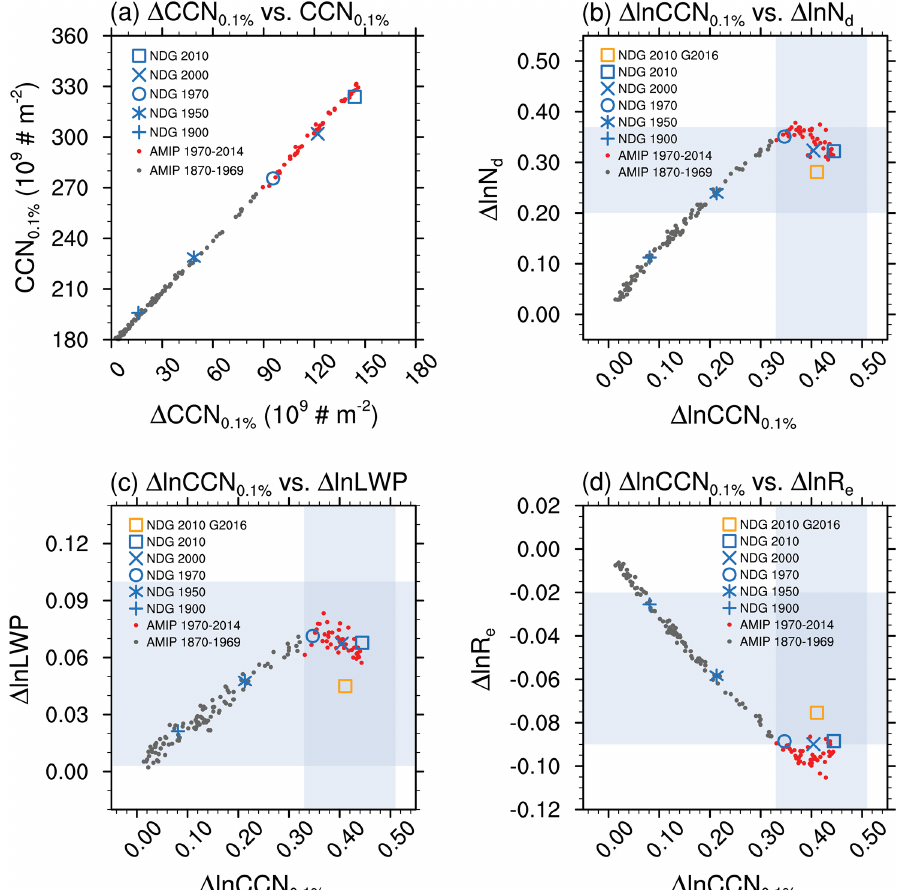
Figure 8. As Fig. 7, but for relationships between the relative changes in CCN ( (cid:49) lnCCN 0 . 1% ) and in liquid cloud properties including droplet number ( (cid:49) ln N d ), liquid water path ( (cid:49) lnLWP), and effective radius of cloud droplets at cloud top ( (cid:49) ln Re liq ). (cid:49) ln X = (cid:49)X/X PD . Dark grey dots indicate estimated values from AMIP PD/PI simulations for the years 1870–1969, while red dots are the estimated values for the years 1970–2014. Each dot represents the ensemble-averaged global annual mean field for a certain year. Blue markers show the estimates based on nudged simulations. The orange square shows the nudged simulation results averaged from conditionally sampled high-frequency data following Ghan et al. (2016), wherein CCN (at 0.3% supersaturation) and N d are sampled below 1km and at the top of liquid clouds. The grey area indicates the multi-model estimated range from Ghan et al. (2016). See Sect. 4.2 for